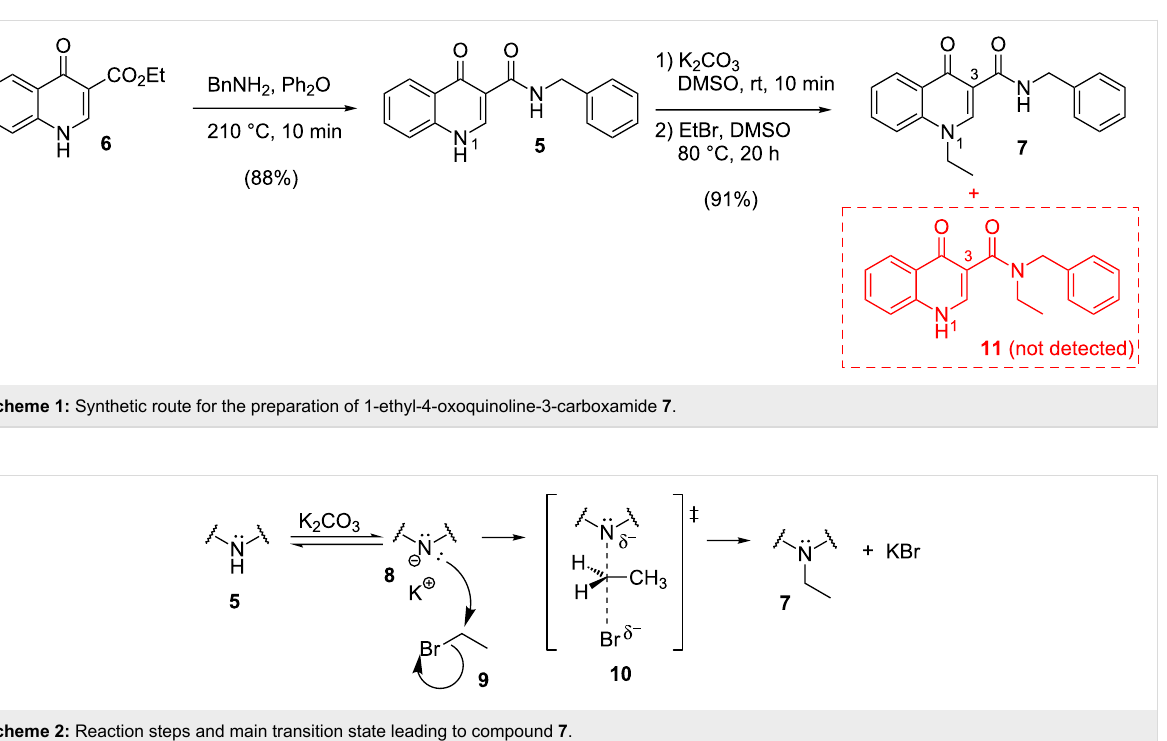
Scheme 2: Reaction steps and main transition state leading to compound 7